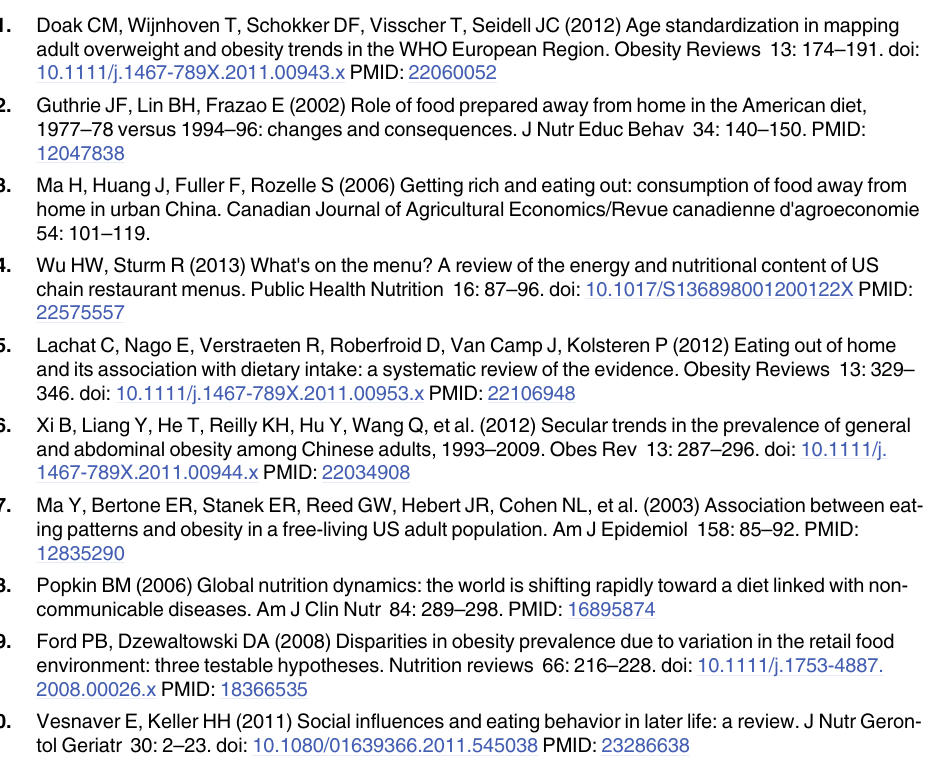
S1 Table. Types and numbers of food stores and food service places identified in the 12 cit- ies of China, n